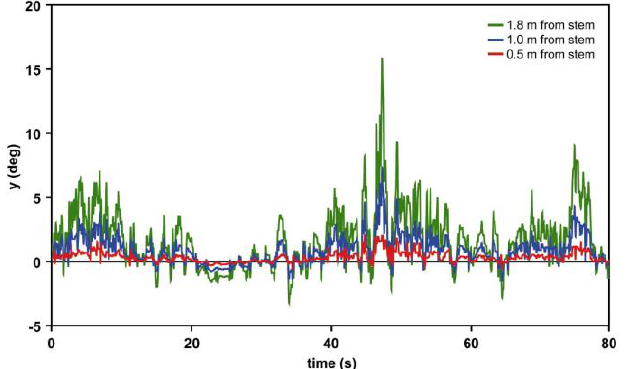
Figure 4. Vertical displacement y (deg) of a branch (no.15) of the Norway maple tree, measured throughout 80 s at 0.5 m, 1.0 m, and 1.8 m from the tree’s stem [53]. The Maple tree shows the highest vertical displacement (around 17°) when measured at 1.8 m from the stem.